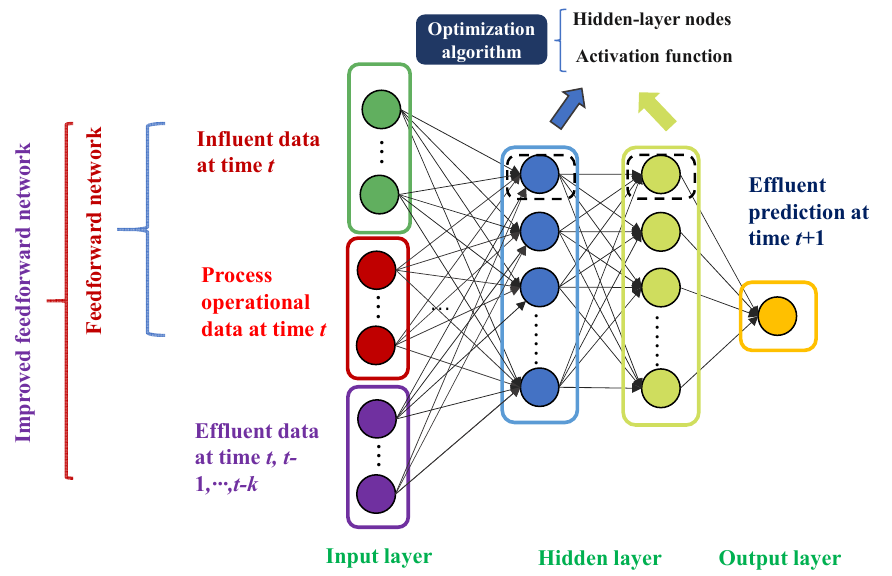
Figure 2. Structure of IFFNN modeling for predicting future WWTP effluent water quality. Generally, the ANN model comprises one or two hidden layers. An increase of hidden layers could reduce predictive accuracy due to overfitting [48]. Therefore, an ANN model with one input layer with multiple input parameters, two hidden layers and one output layer with one neuron (i.e., one designated effluent water quality indicator) was adopted. The number of neurons and most appropriate activation functions in the hidden layer were first specified by the user and then optimized by the optimization algorithm to achieve the best fit between modeling and measured output